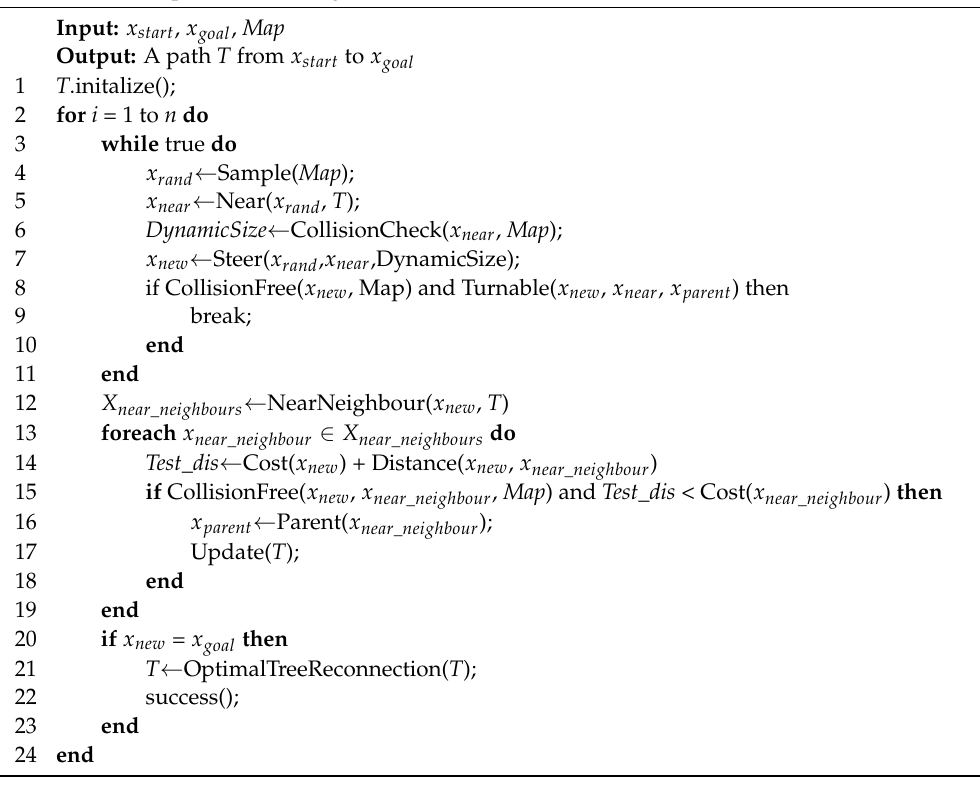
Algorithm 1 Improved RRT* Algorithm